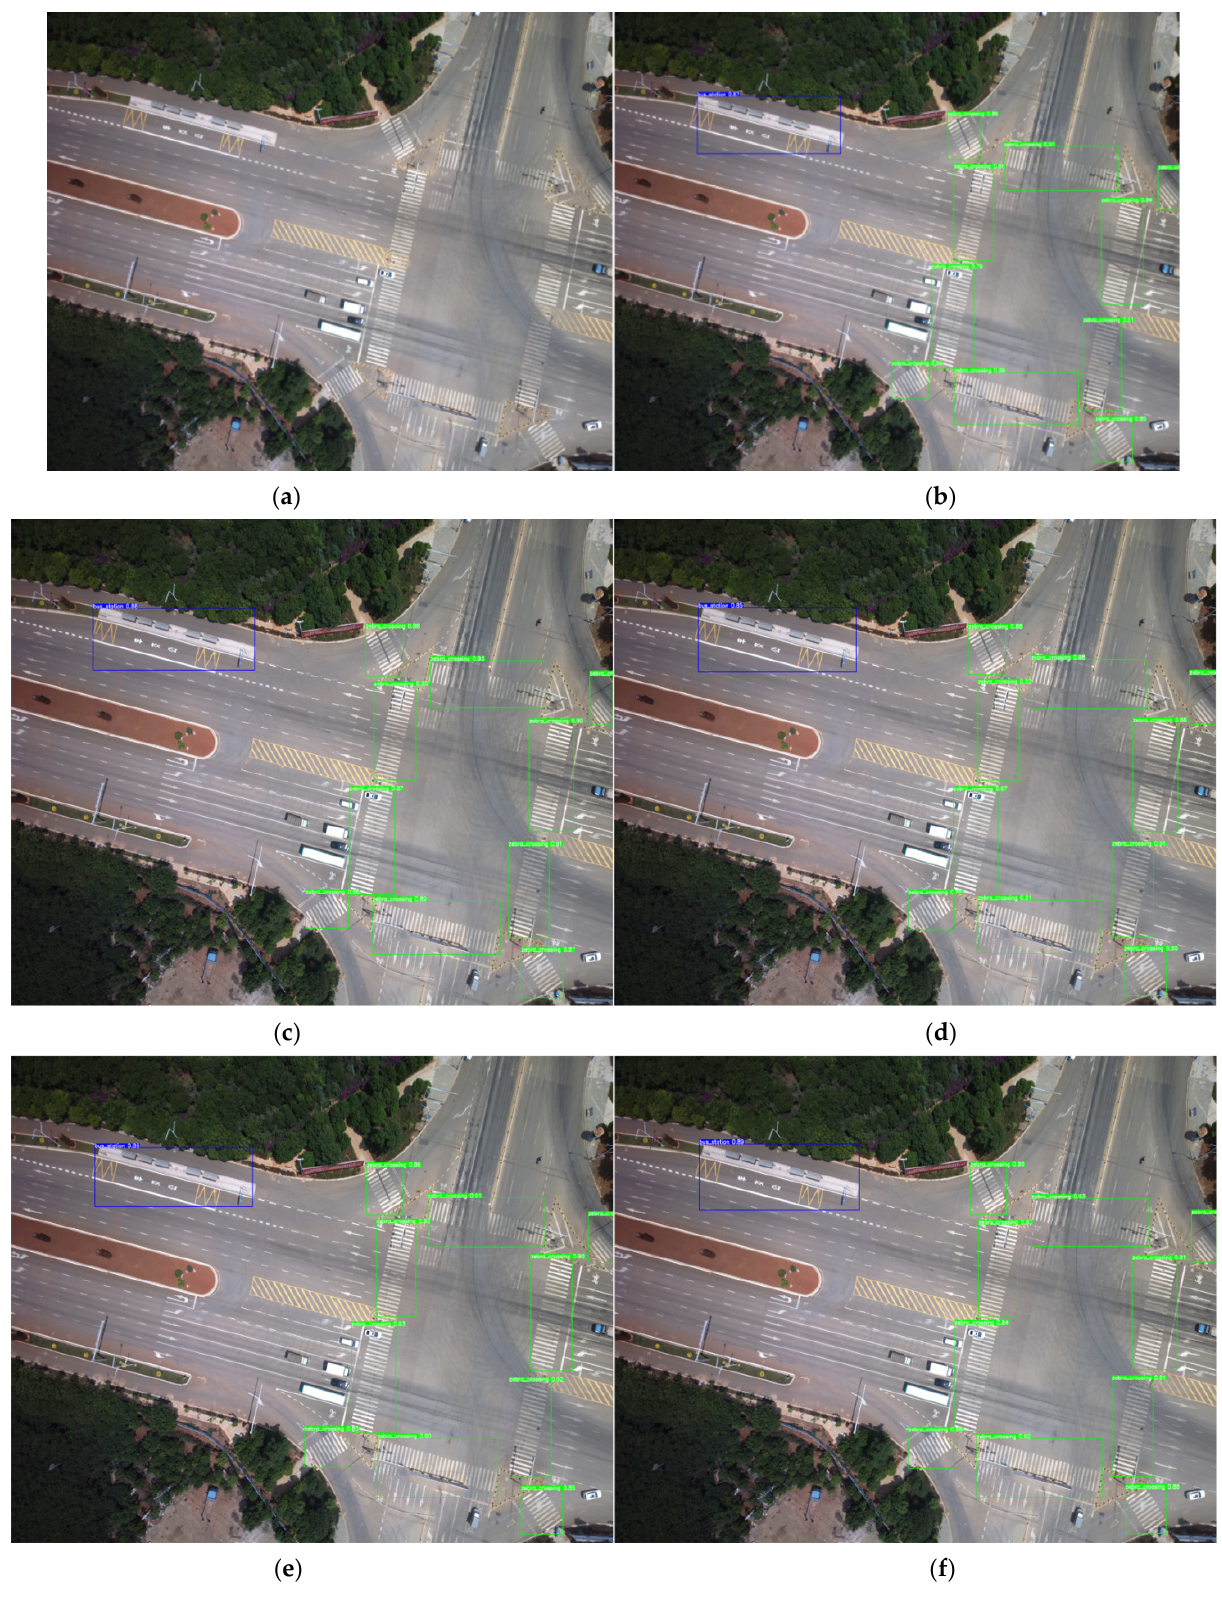
Figure 9. Detection results in normal road scenarios: ( a ) detection of the original image; ( b )YOLOv5; ( c ) YOLOv5 with SPPF; ( d ) YOLOv5 with K-means++; ( e ) YOLOv5 with ASFF; and ( f ) ASFF-YOLOv5.